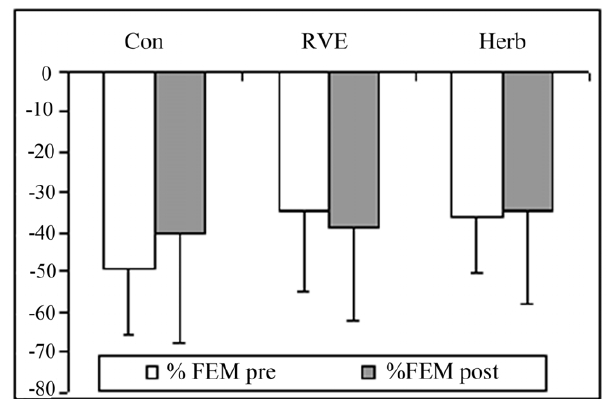
Figure 2. Percentage change in the flow velocity of the femoral artery (FEM) from supine to tilt positions. The FEM was measured by Doppler ultrasonography as detailed in the Materials and Methods section. The percent change in FEM from supine to tilt positions post- HDBR was similar to pre-HDBR in Con, RVE and Herb groups.